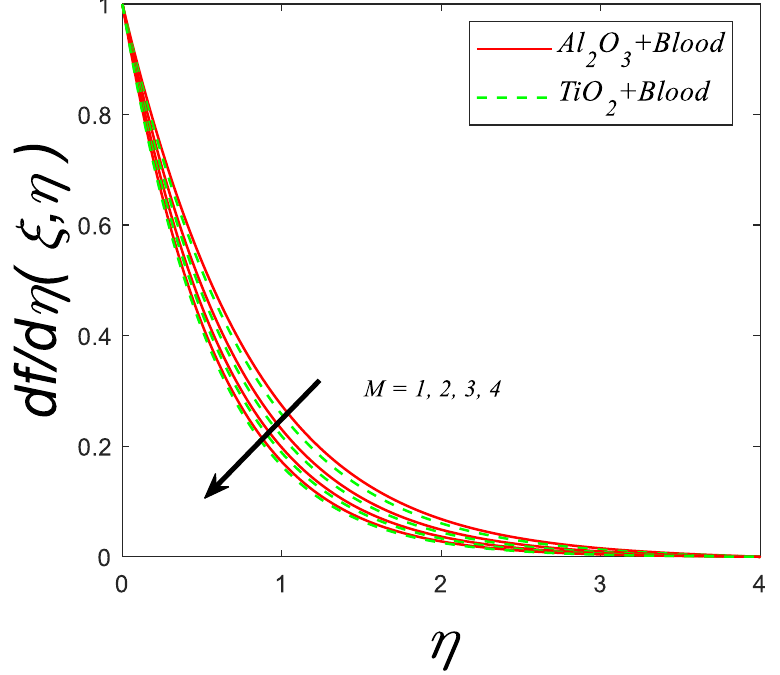
, 𝜉 = 0.1,𝑅𝑑 = , ξ = 0.1, Rd = 0.1, 3 3